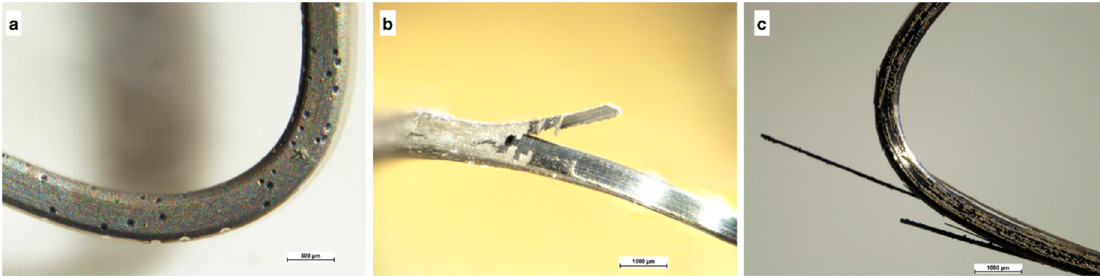
+ WS 2 , and ( c ) Ni 2